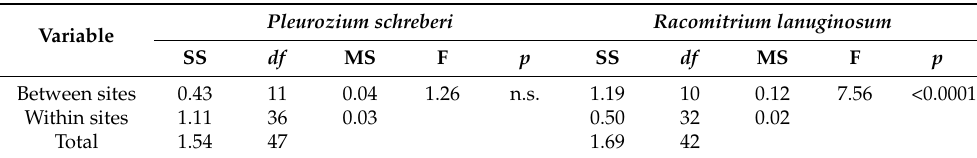
Table 1. One-way ANOVA of Fv/Fm and effects of altitudinal site prior to the experiment for P. schreberi and R. lanuginosum